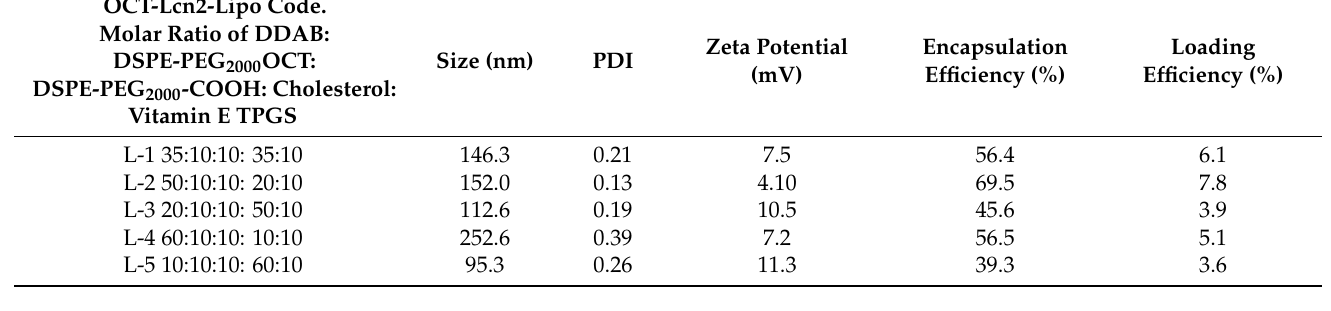
Table 2. OCT-Lcn2-Lipo formulation development.